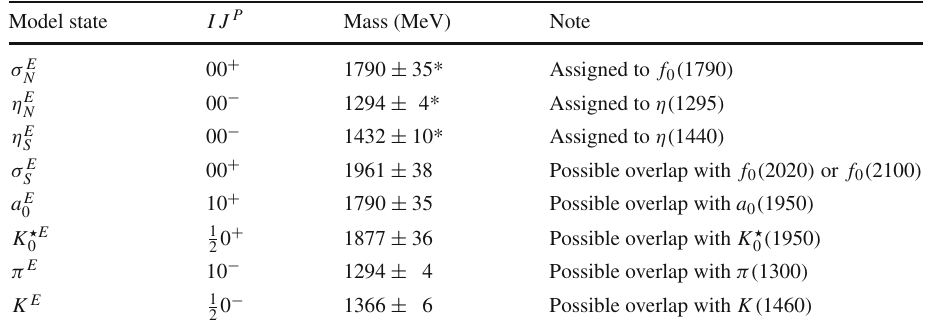
Table 3 Masses of the excited states present in the